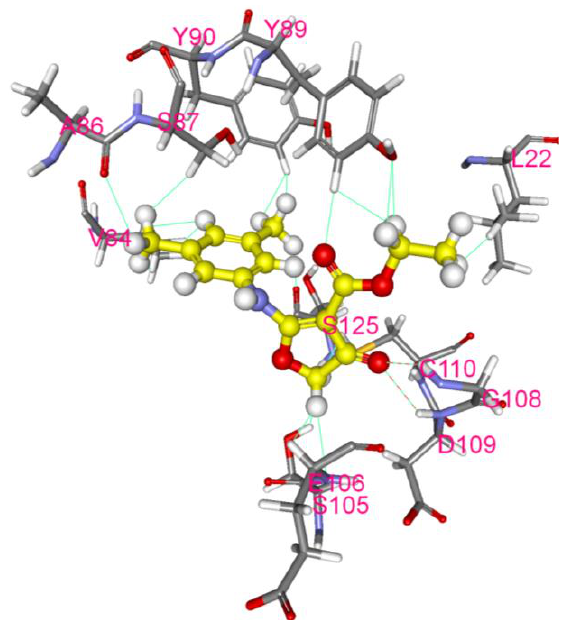
Figure 7. Molecular modeling of interaction between CW-33 and 2A protease. Compound CW-33 (ball and stick, yellow) docked into the active site of EV-A71 2A protease sandwiched between N- and C-terminal domains. Compound CW-33 docked well with 3w95 via hydrogen bonding and hydrophobic reaction, binding amino acids shown as sticks and labeled.